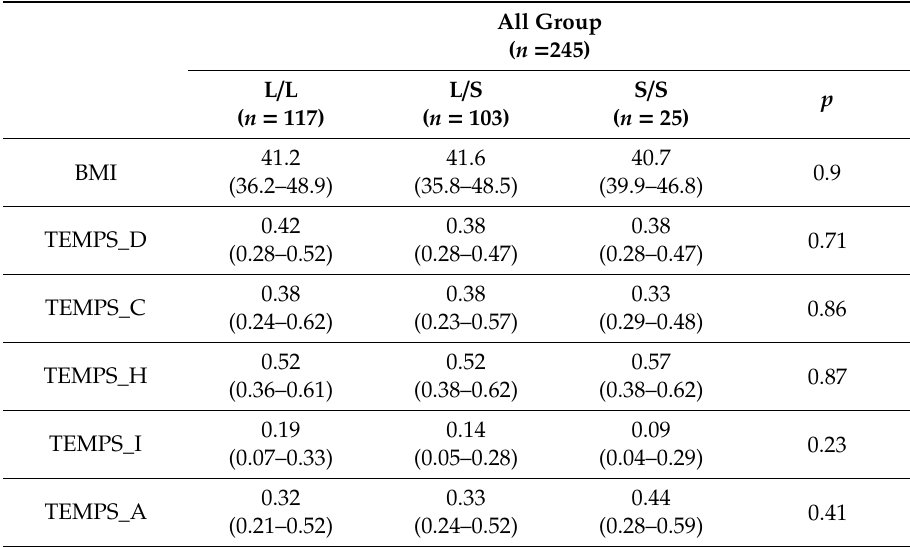
Table 4. DAT polymorphisms and TEMPS-A scale results in study group.